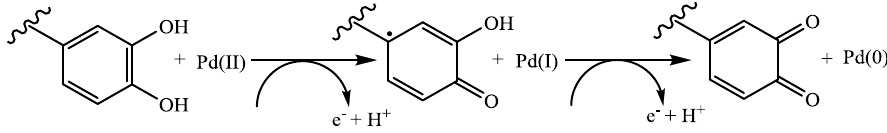
Figure 1. UV-Vis spectrum of plant extract and Pd NPs at different times.